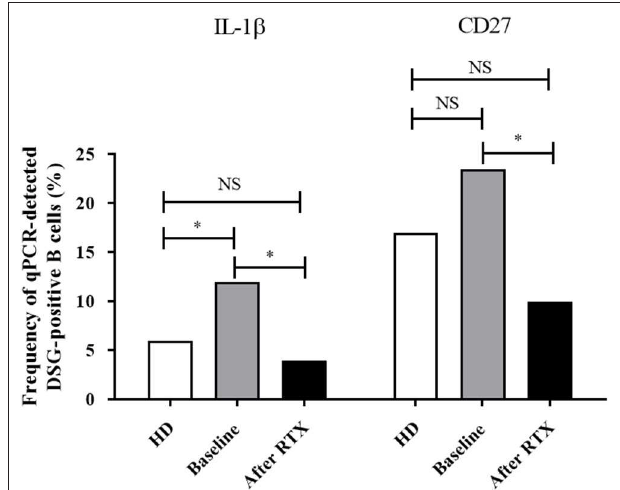
FIGURE 3 | Frequency of cells with detectable mRNA encoding for IL-1 β and CD27 in one-cell sorted desmoglein-positive autoreactive B cells from healthy donors (white columns n = 107 cells) compared to pemphigus patients before treatment (gray columns, n = 191 cells) or after rituximab treatment (black columns, n = 115 cells). Frequencies were compared using the Fisher’s exact test.